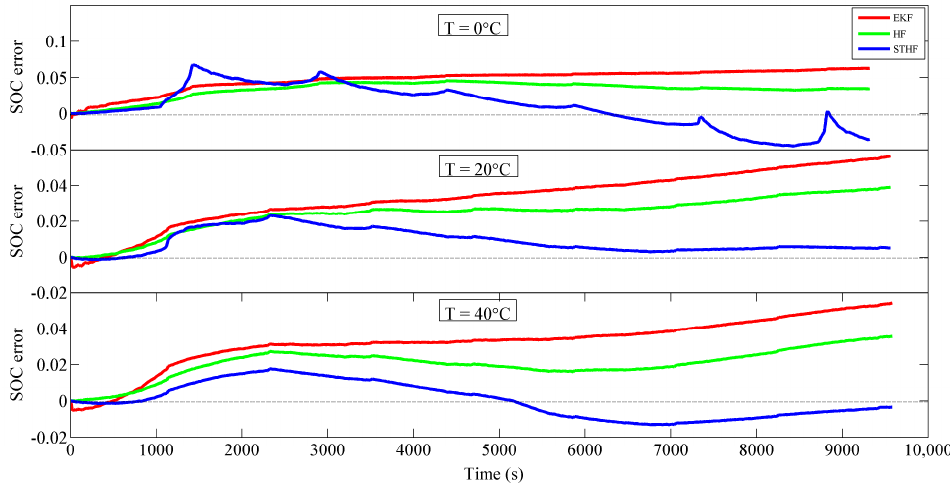
Figure 9. Estimation errors of STHF, HF and EKF with 0.05 A current-biased noises.